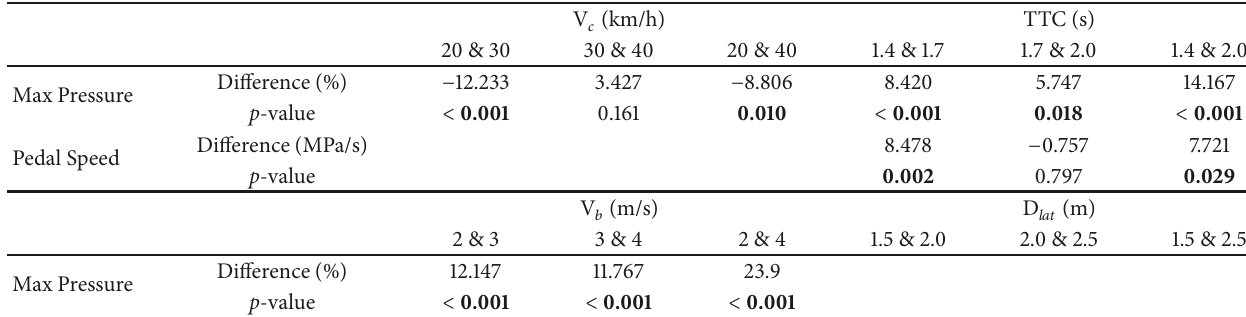
Figure 7: The average ( ± SD) of Max Pressure and Pedal Speed at three levels of the four parameters in SCR. Table 6: Post hoc analysis for Max Pressure and Pedal Speed in